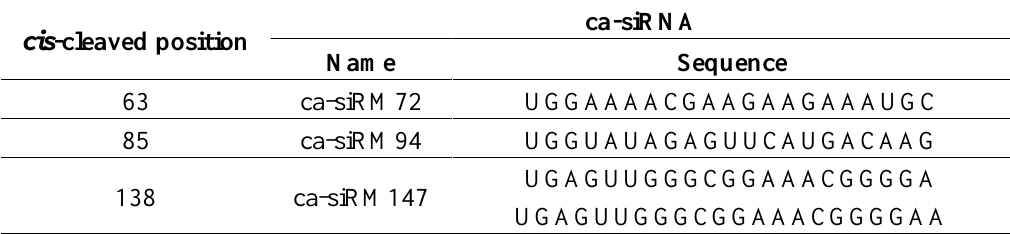
Table 1. Validated cis -cleaved positions on vvi TAS3 transcript and their